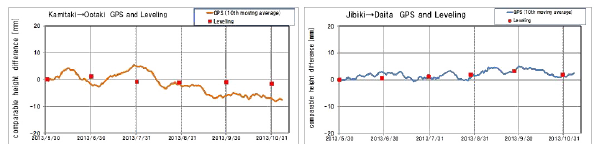
Figure 5. Comparable height difference GPS and Leveling.